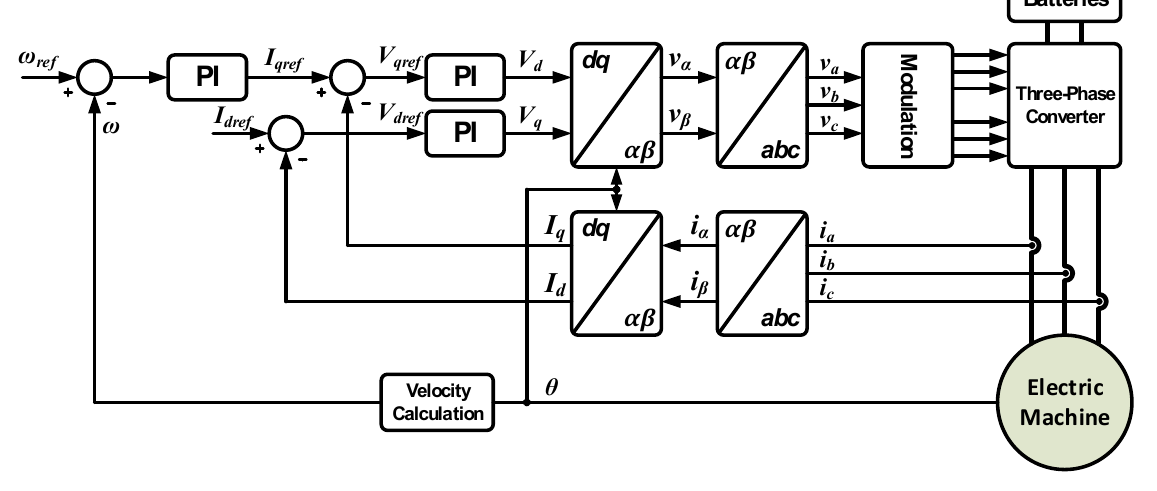
Figure 8. Block diagram of field-oriented control (FOC).